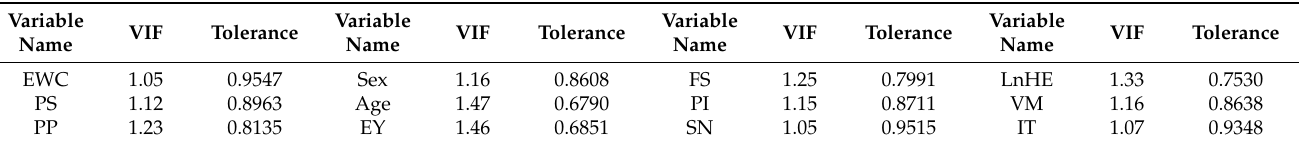
Table 5. Multicollinearity